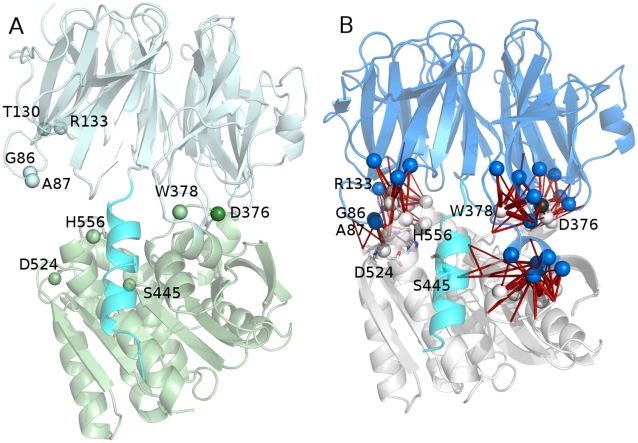
Correlated motions at the interdomain interface.A) The open structure of ApAAP identified by X-ray crystallography [33] is shown as a reference. The observed crucial residues for mediating cross-correlated motions in the simulations of the ApAAP closed form (panel B) are shown as spheres. B) The dynamical cross-correlations at the interdomain interface (correlation threshold of 0.4) in wild type ApAAP are shown as red lines. The β-propeller and the catalytic domains are shown in pale-cyan (A)/blue (B) and pale-green (A)/white (B), respectively, whereas the α1-helix is highlighted in cyan. The hinge residue proposed for the opening of the catalytic cleft, D376 is shown in dark green (A) and black (B), respectively.